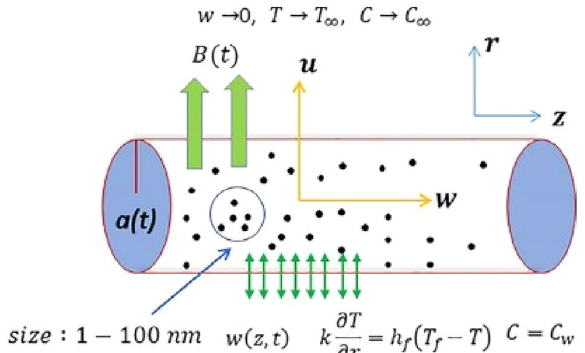
Figure 1. Flow over the stretching